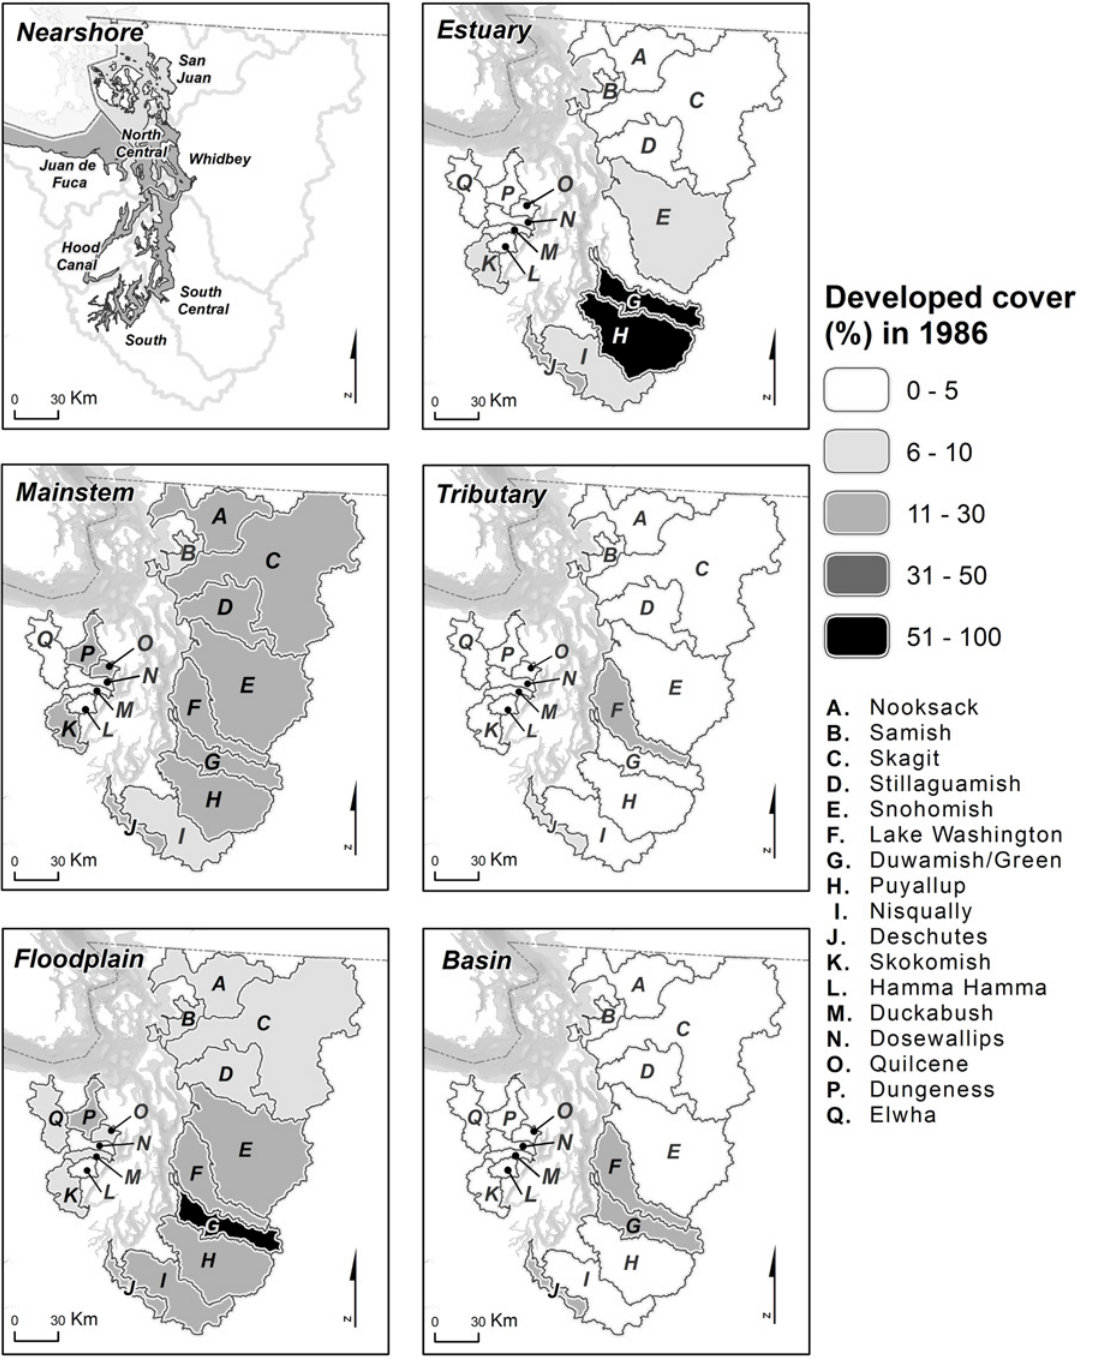
Fig 4. Percentage of Developed Land Cover in 1986: Watershed Scale. Percentage of developed land cover at the start of the time series in 1986, summarized at the watershed scale for six habitat areas. Format is identical to that in Fig 3.